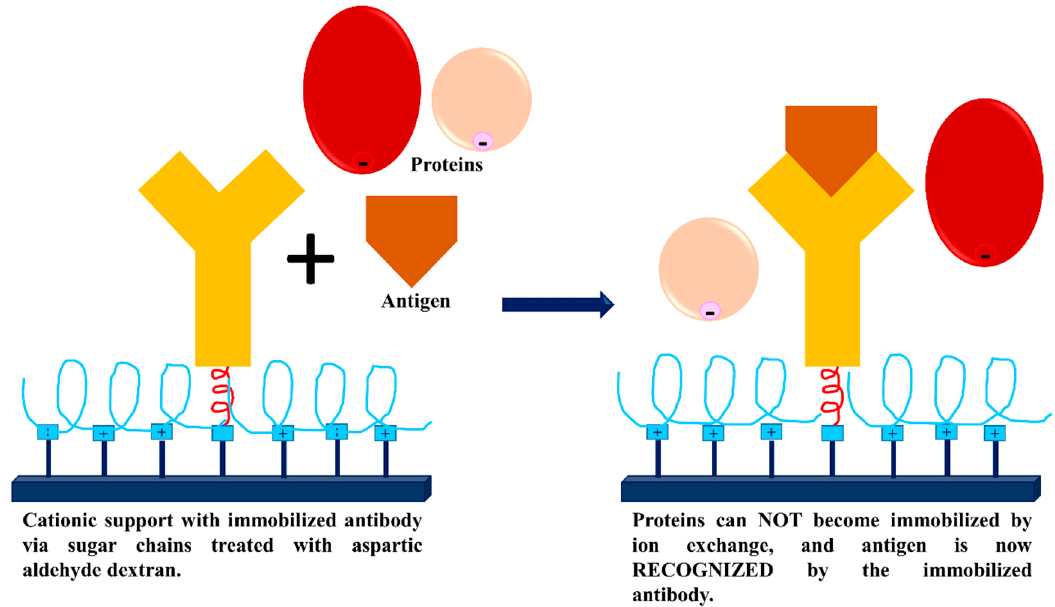
Figure 13. Antibodies immobilized on aminated supports coated with ASP-dexOx: selective coating of the support permit to maintain functionality of the immobilized antibody and avoid no specific adsorption of proteins on the support surface.